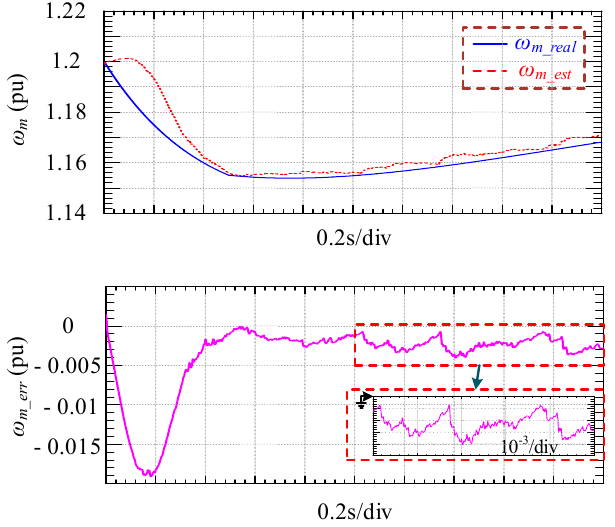
Figure 20. Real and estimated rotor speeds with noises.